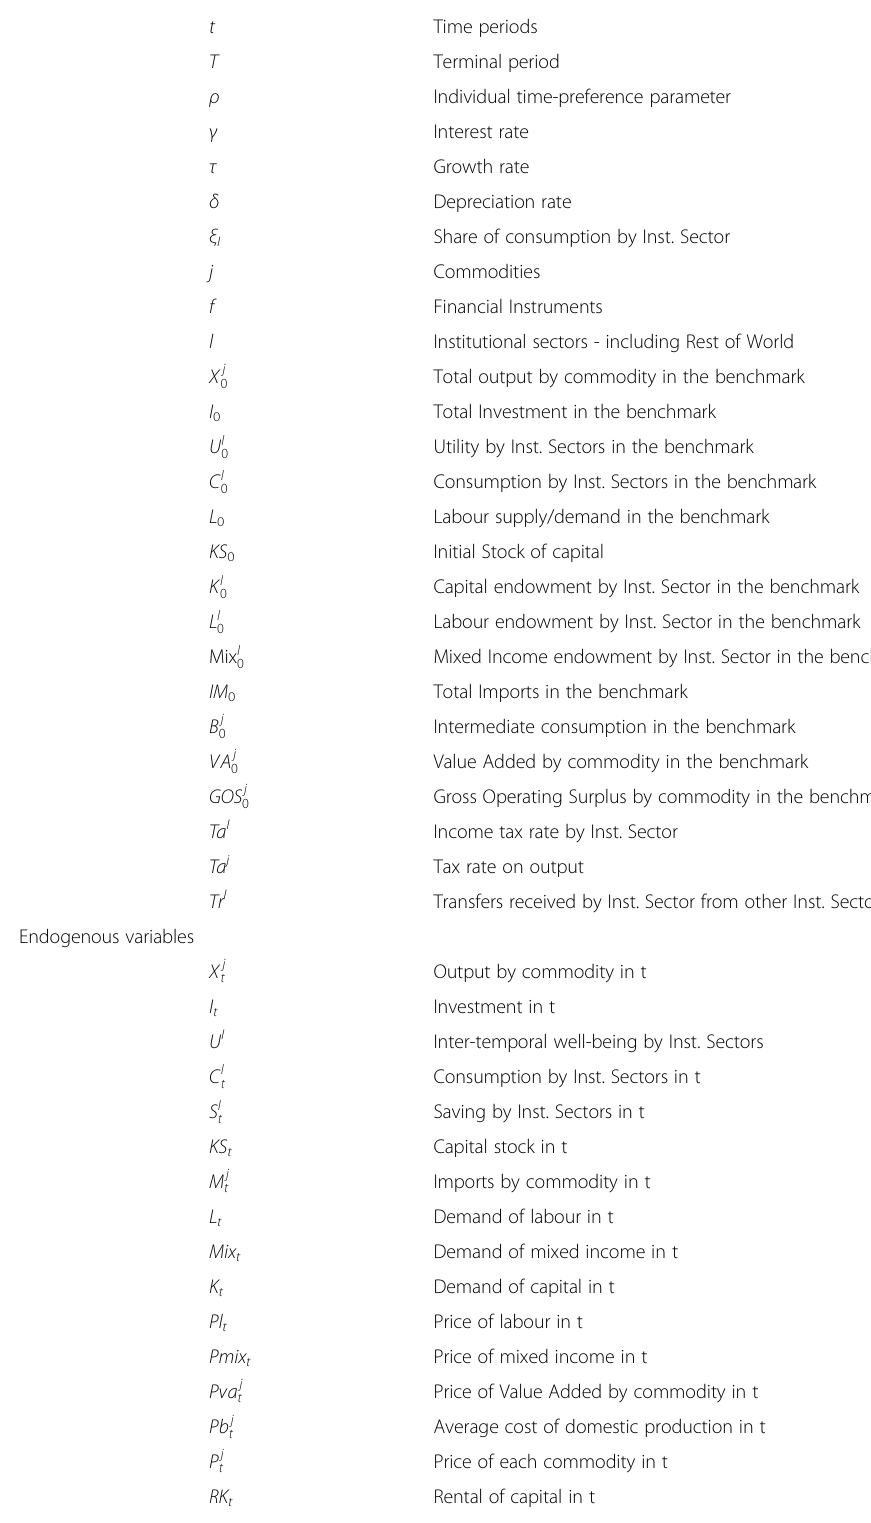
Table 5 List of parameters and variables